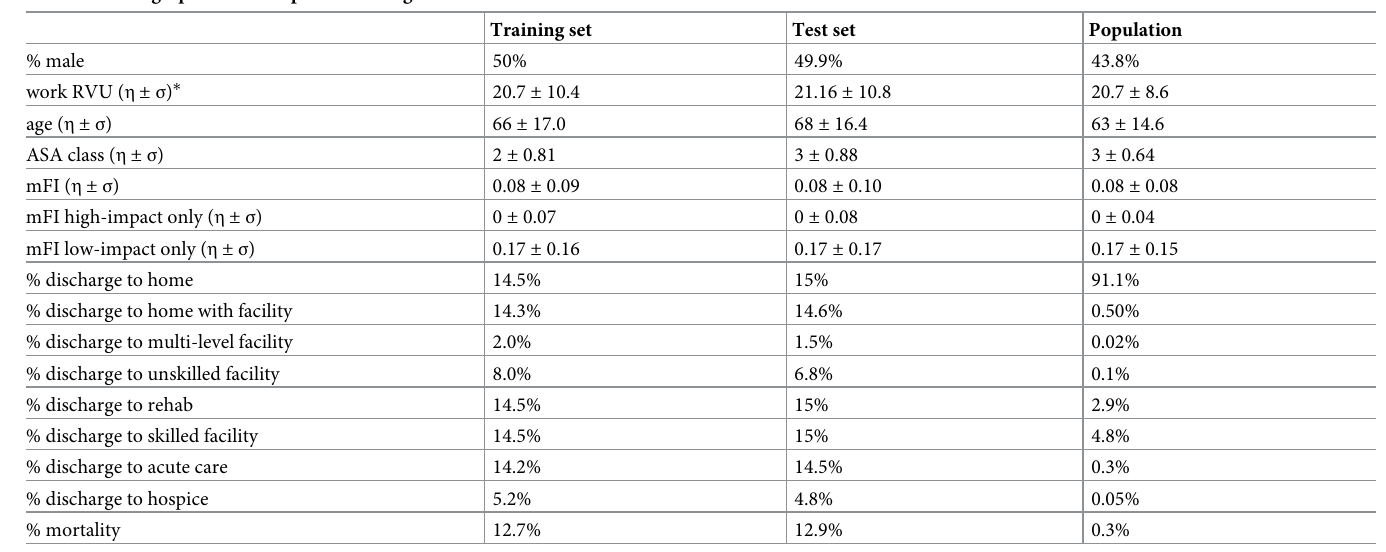
Table 1. Demographics for composite training and test